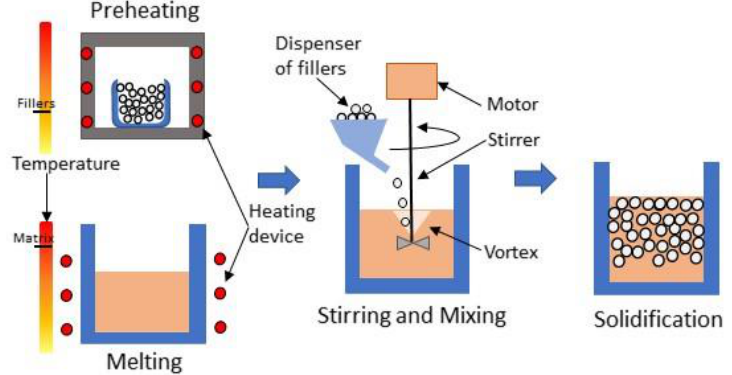
Figure 2. Conventional stir casting process scheme for MMSFs.